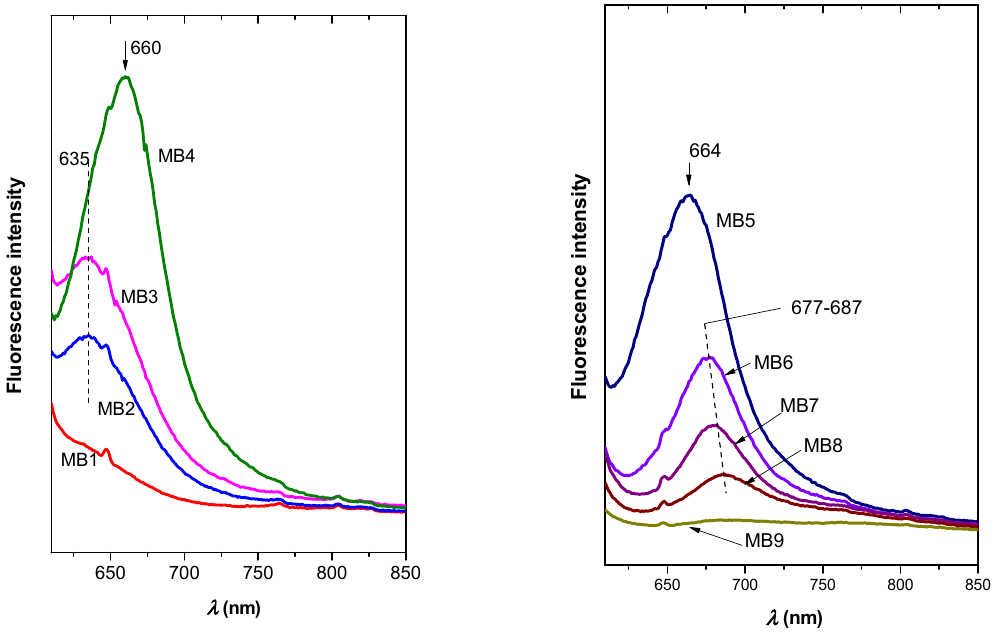
Figure 8. Fluorescence spectra of the composites of PCL discs with MB1-MB9 composite films.